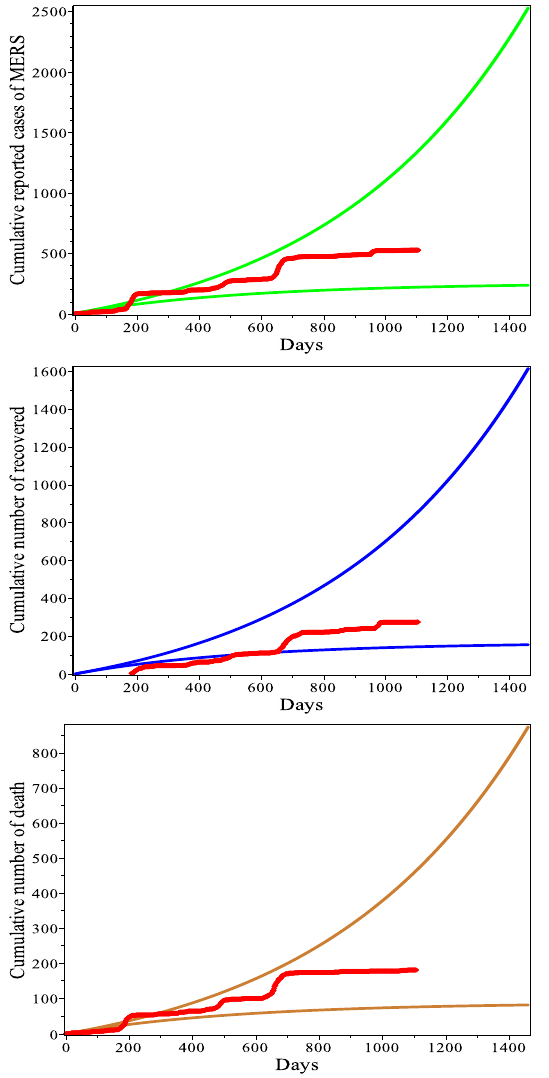
Fig. 9: The case of combined variations in β , (cid:15) E and γ . Variations in cumulative reported cases of MERS (T), cumulative number of recovered (M), and cumulative number of death (B), as ω varies randomly in Ω comb